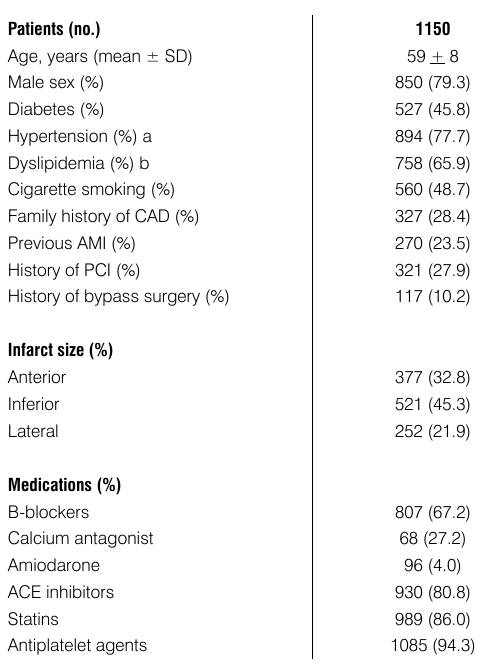
Table 1. Baseline Clinical Characteristics.